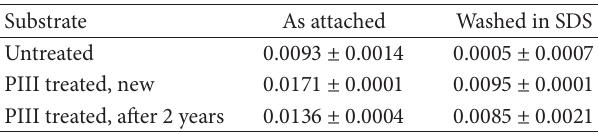
T 1: Amount of attached HRP protein (determined from FTIR ATR using (5)) on UHMWPE treated by PIII with 20keV energy Nitrogen ions at 10 16 ions/cm 2